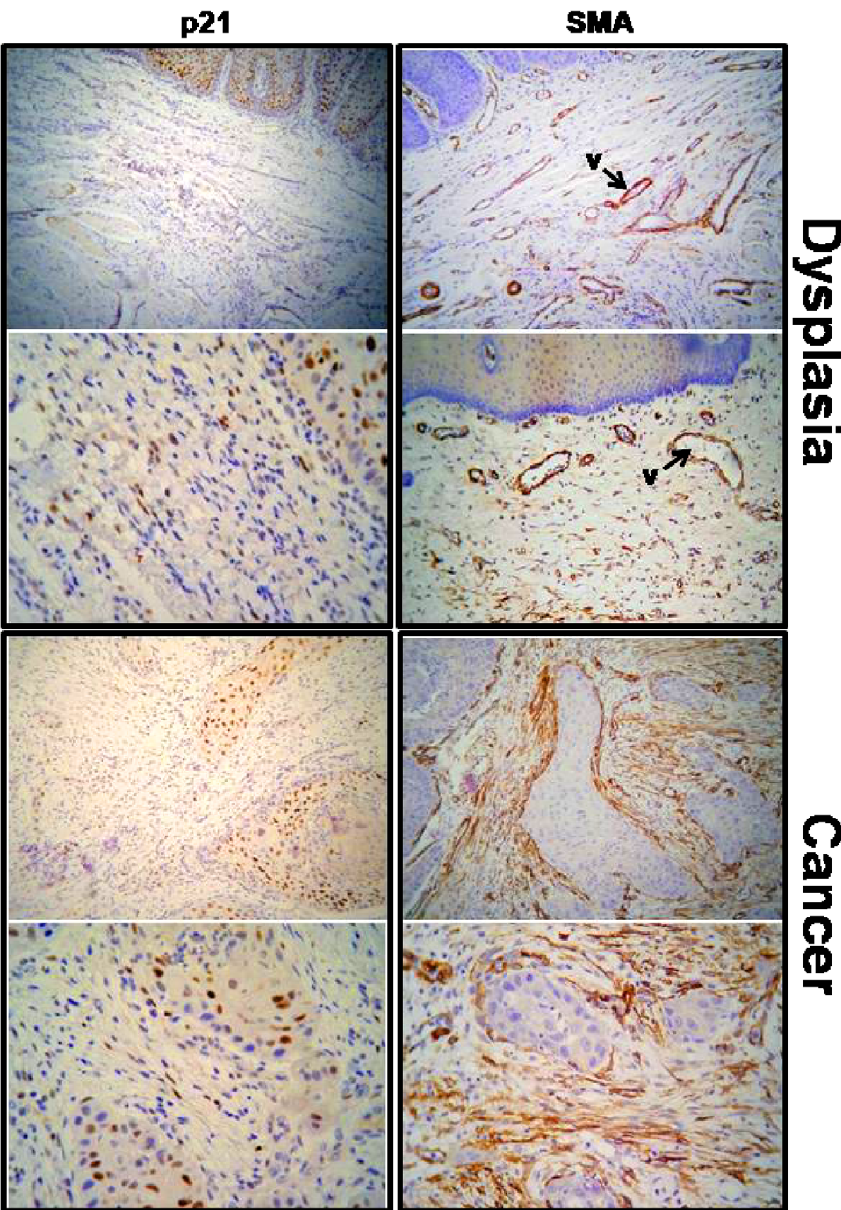
Fig. 1. Representative microphotographs of p21 and SMA immunopositivity (brown staining) in dysplastic and malignant lesions. Upper and lower panel in each set of pictures corresponds to different magnifications (objectives used 10 × and 40 × , respectively). Antibodies were obtained from Santa Cruz Biotechnology (Santa Cruz, CA, USA) and immunostaining was performed by using the Kwik-DAB kit (ThermoShandon, Pittsburgh, PA, USA), following the manufacturer’s instructions. Before observation, a weak counter stain with hematoxylin was performed. Arrows indicate blood vessels that are positive for